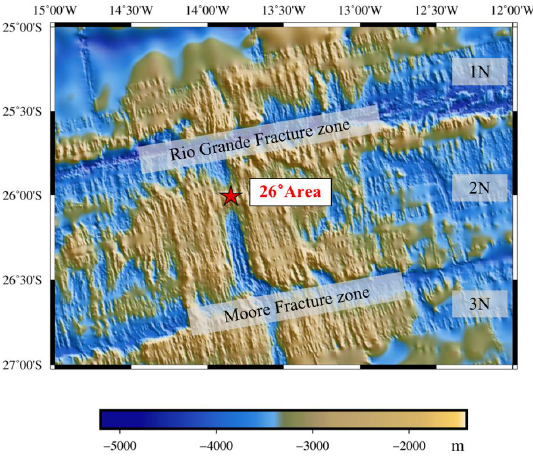
Figure 1. Study area (The red star represents the Xunmei hydrothermal field).